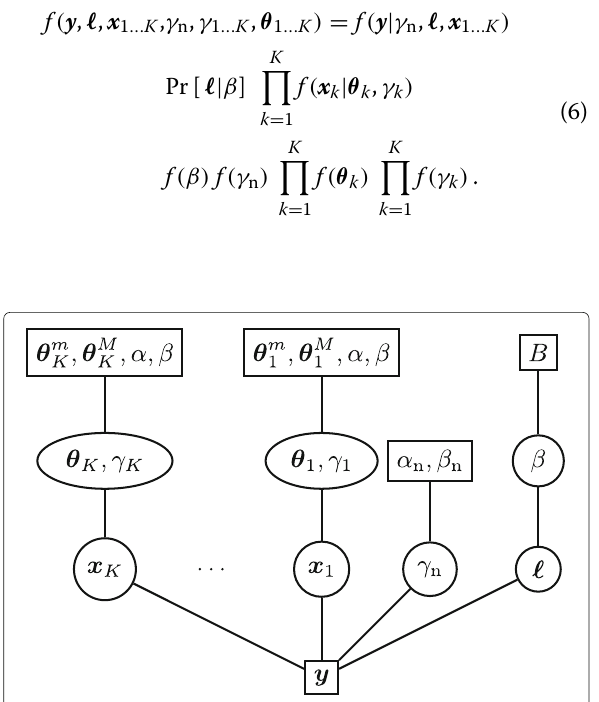
Fig. 2 Hierarchical model: the round/square nodes show the estimated/given variable. The x k are the textured images (Gaussian density) and the θ k , γ k are the texture parameters. (cid:2) is the label set (Potts field) and β is the label parameter (granularity coefficient). The observed image is y . See also the notation table (end of the